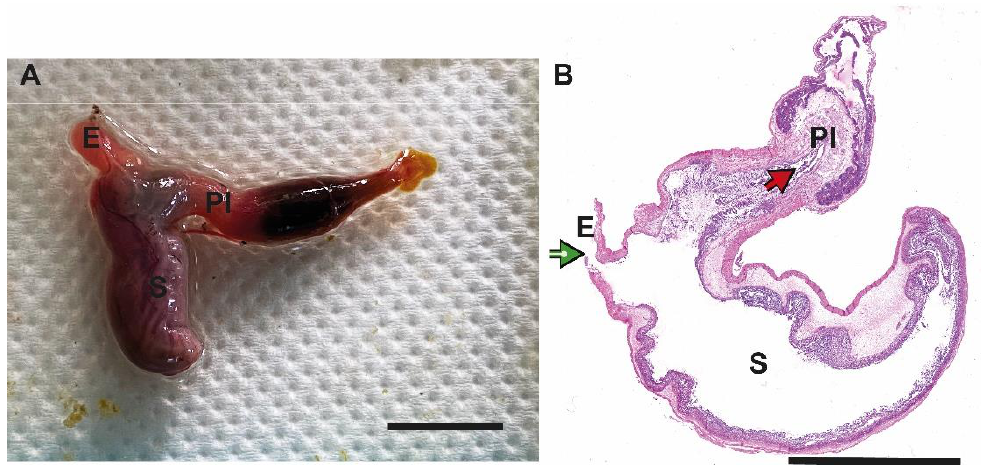
Figure 1. Gross morphology and microscopical organization of esophagus and stomach of Nile tilapia. A: esophagus (E), stomach (S) and proximal portion of the intestine (PI); B : Hematoxylin/Eosin staining of a para-sagittal section of the two organs. In the upper left is visible the esophagus outlet (green arrow), while in the upper right is the pyloric sphincter (red arrow). The figure is representative of a reconstructed mosaic of 180 individual photos taken using a 20x objective to visualize in detail the stratigraphy of the organs. Scale bars = 1 cm .